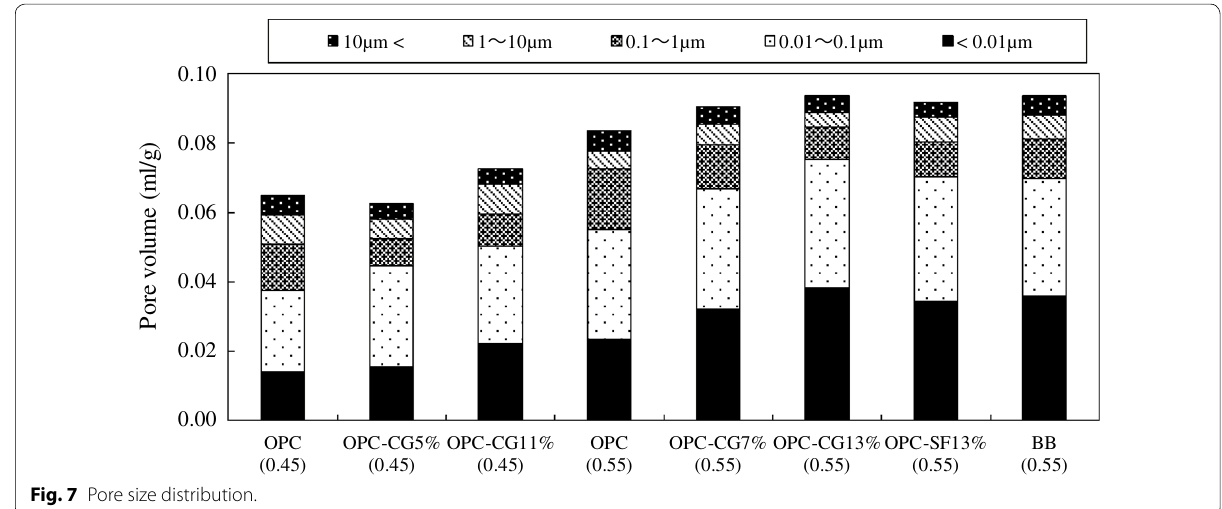
Fig. 7 Pore size distribution.